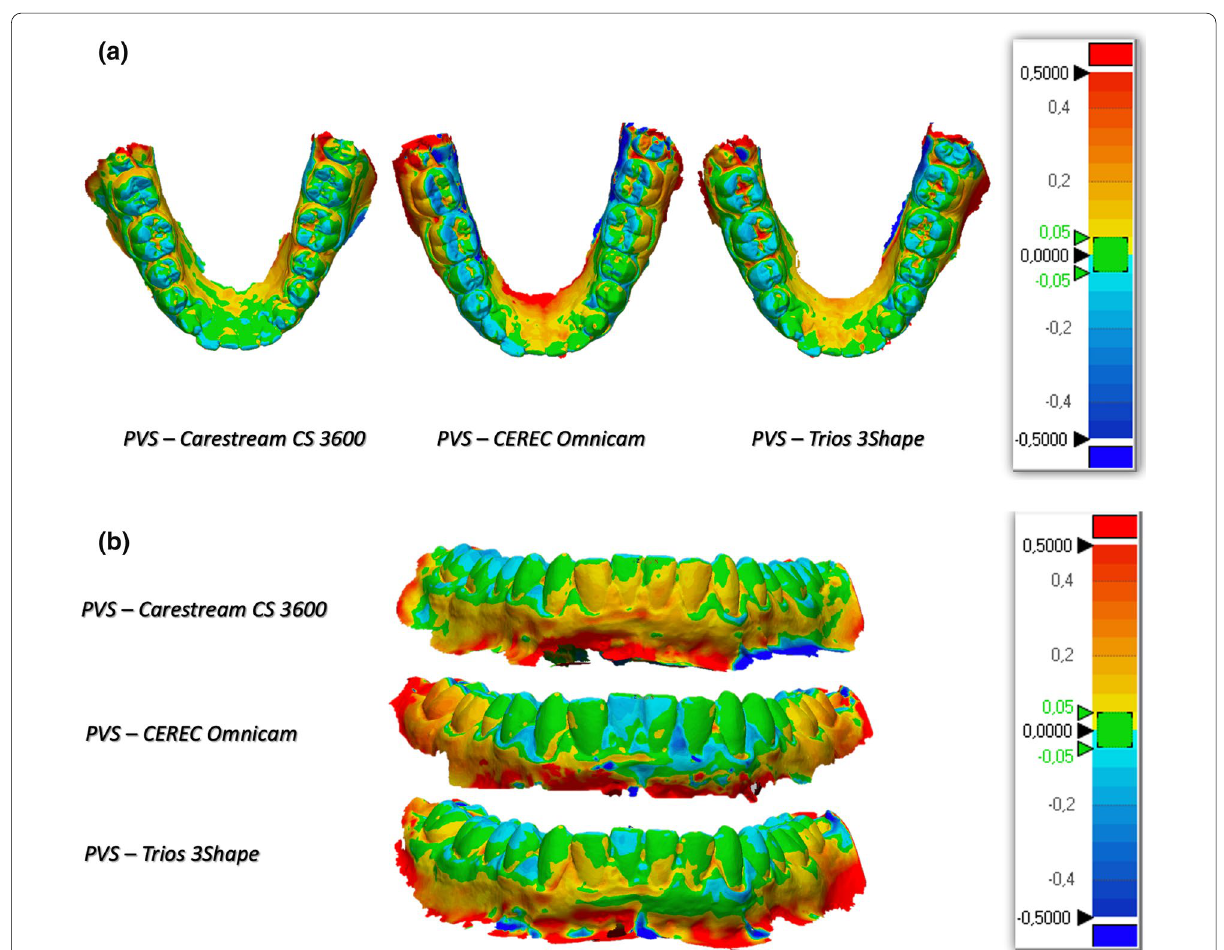
Fig. 2 a Occlusal view of the 3D comparison of units B (Carestream CS 3600), C (CEREC Omnicam) and D (Trios 3Shape) with the PVS